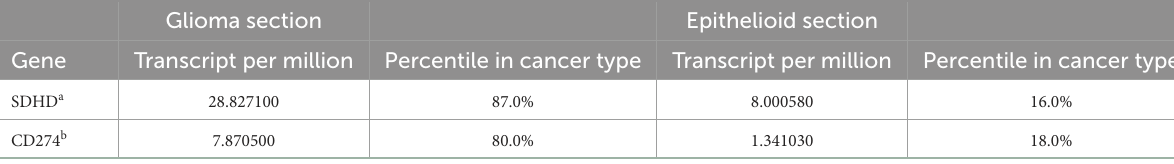
TABLE 1 Gene expression by whole-transcriptome sequencing.